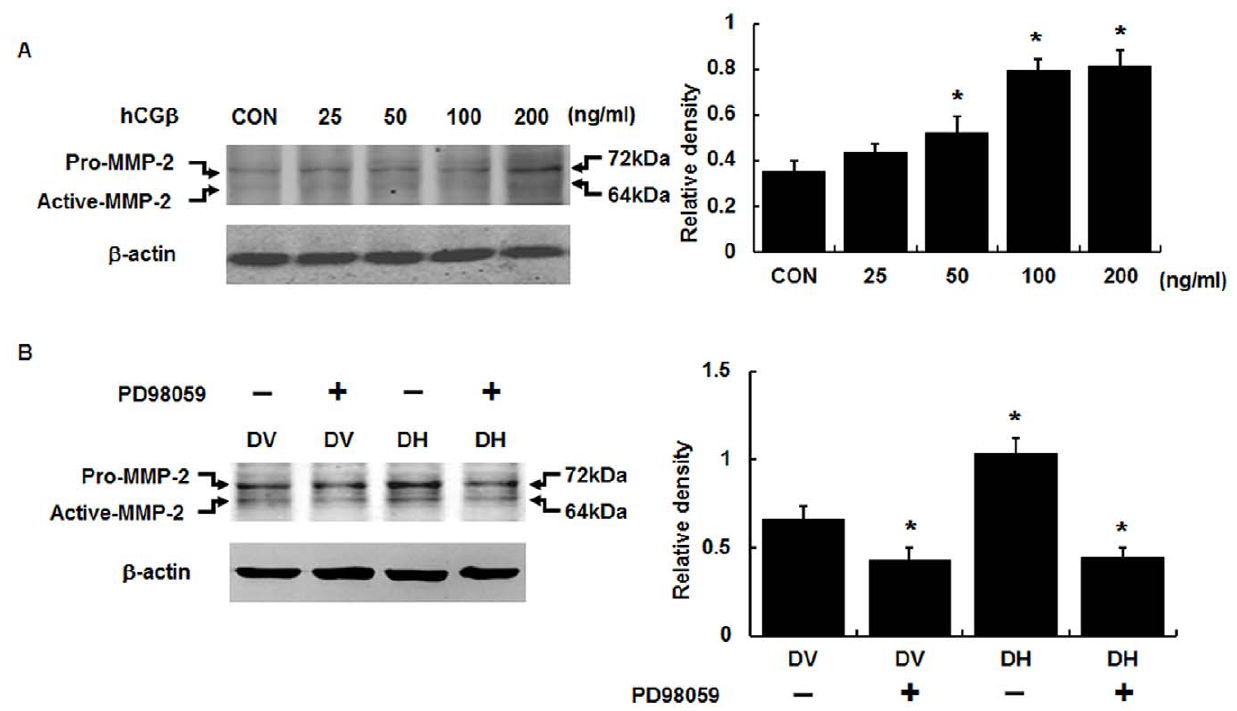
Figure 4. HCG b increased MMP-2 expression and via ERK1/2. (A) We treated non-transfected DU145 cells with 0, 25, 50, 100, and 200 ng/ml hCG b for 1 h, Western blot indicated that hCG b standards upregulated MMP-2 in a dose-dependent manner, at the concentration of 200 ng/ml, MMP-2 expression reached the peak. (B) We treated DH and DV cells with or without PD98059 (25 m M) 30 min and then incubated for 24 h with serum-free medium, Western blot showed that hCG b upregulated MMP-2 expression and PD98059 abolished those increase. The sizes for pro-MMP-2 and active-MMP-2 are 72 Kd and 64 Kd, respectively. *, indicates P , 0.05 versus control. Data were shown as means 6 SEM from three separate tests.